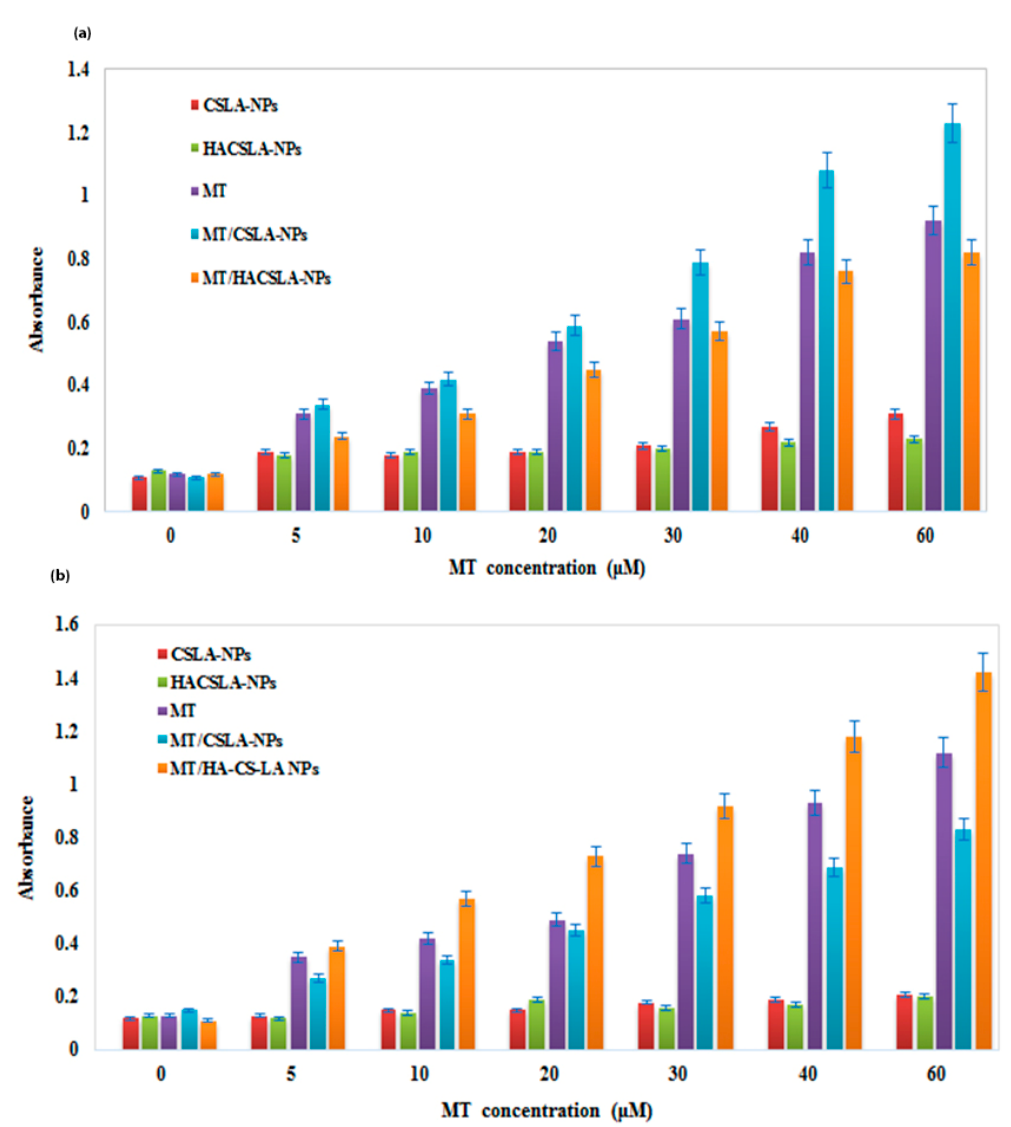
Figure 9. The activity of Caspase 3 was determined using the Caspase Colorimetric Assay Kit in ( a ) MCF-7 and ( b ) BT-20 cells. All data represented by mean ± S.E.M ( p < 0.05).